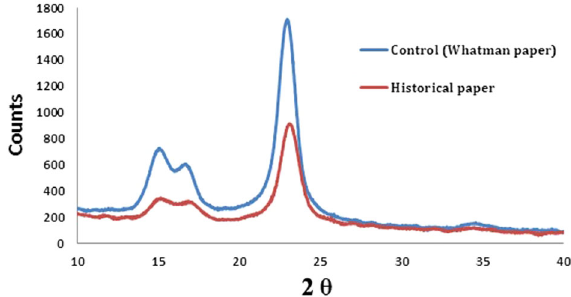
Fig. 4 Measurment of the crystallinity values. X-ray diffraction analysis for detect the crystallinity degree of a historical paper compared to a control (Whatman No. 1).